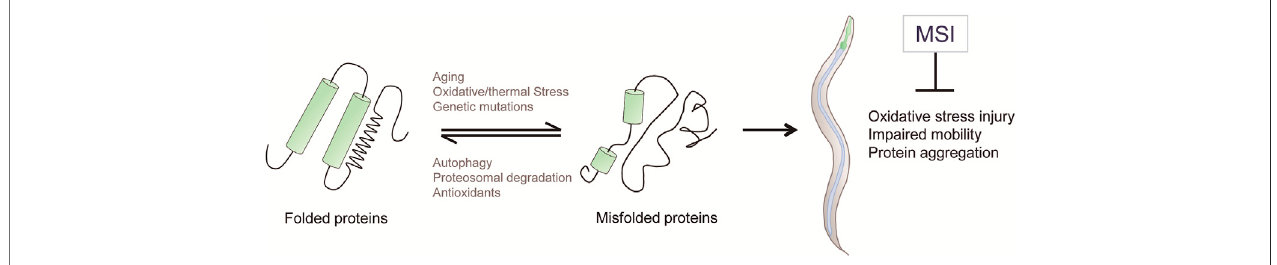
FIGURE 5 | Schematic diagram depicting the cytoprotective activities of the imidazolium salt MSI, supporting its role as an antiproteotoxic agent. Cellular protein quality control systems, such as autophagy, proteosome and antioxidants, act to prevent or degrade misfolded proteins. When the capacity of these protective mechanisms is overwhelmed, abnormal proteins can accumulate into toxic protein aggregations that generate cellular damage. MSI reduces oxidative stress injury and pathological phenotypes associated with proteotoxicity